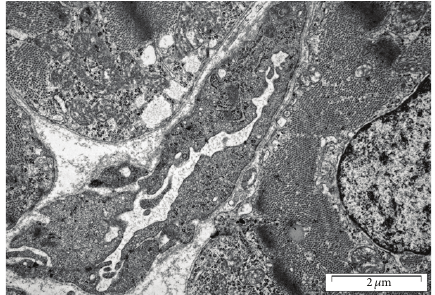
Figure 4: Ultrastructure of a developing subepicardial lymphatic vessel in a 4-day postnatal mouse heart. A tortuous appearance of LEC and anchoring filaments are